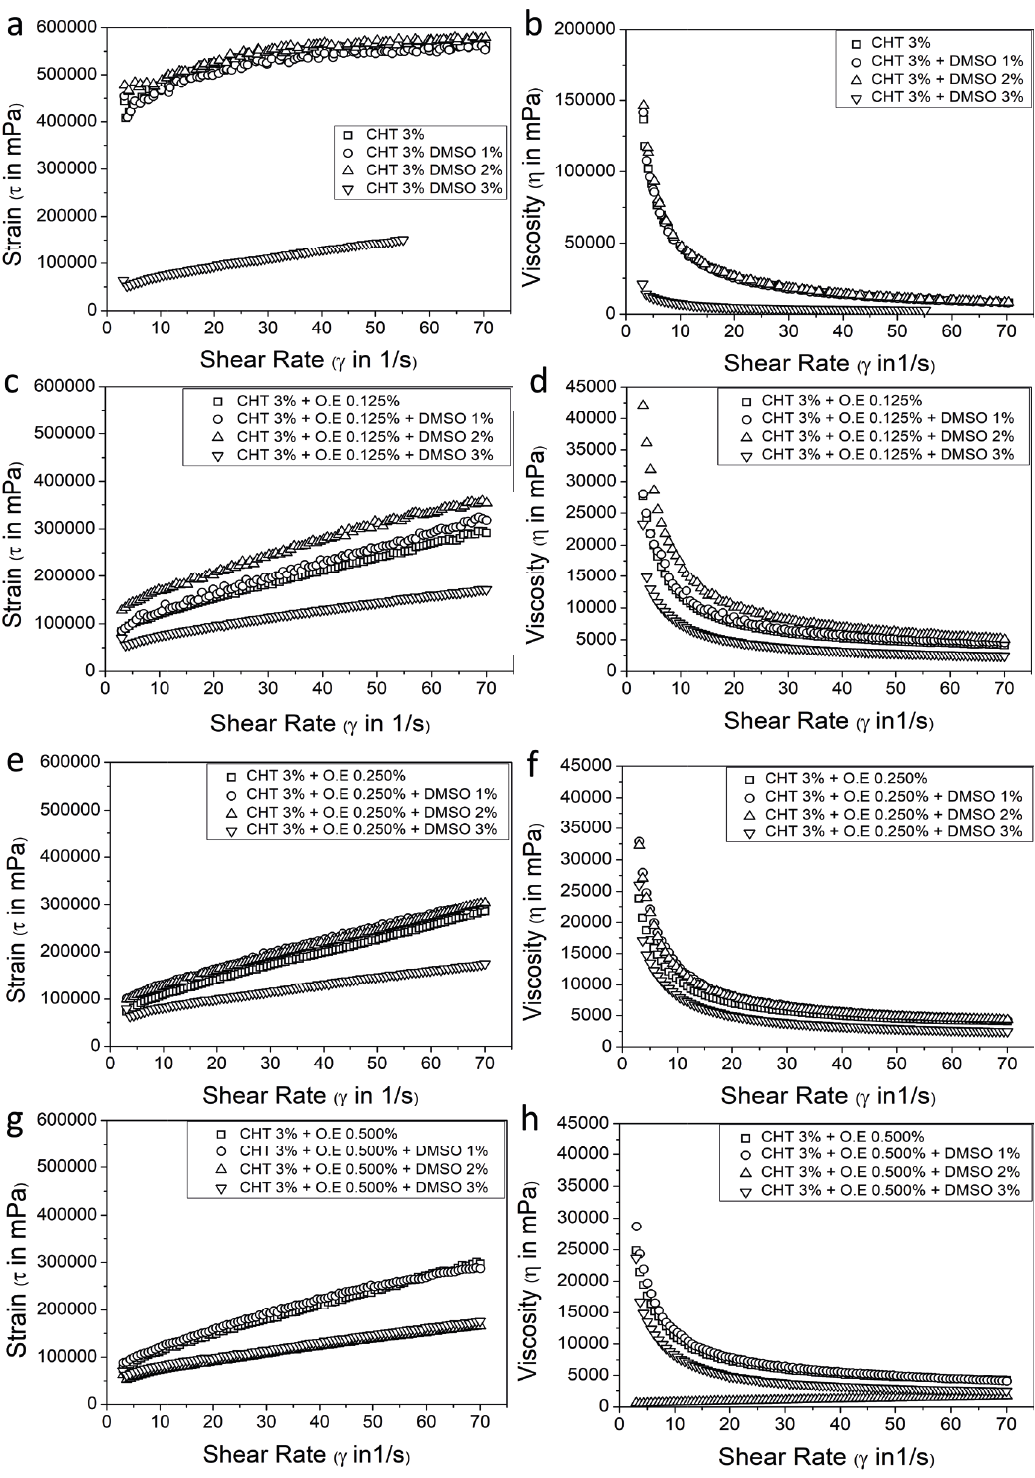
Figure 2. Stress curves and viscosity (a, b): formulations F1-F4 in the absence of Schinus molle essential oil; (c, d): formulations F5-F8 with Schinus molle essential oil 0.0125%; (e, f): formulations F9-F12 with Schinus molle essential oil 0.250%; (g, h): formulations F13-F16 with Schinus molle essential oil